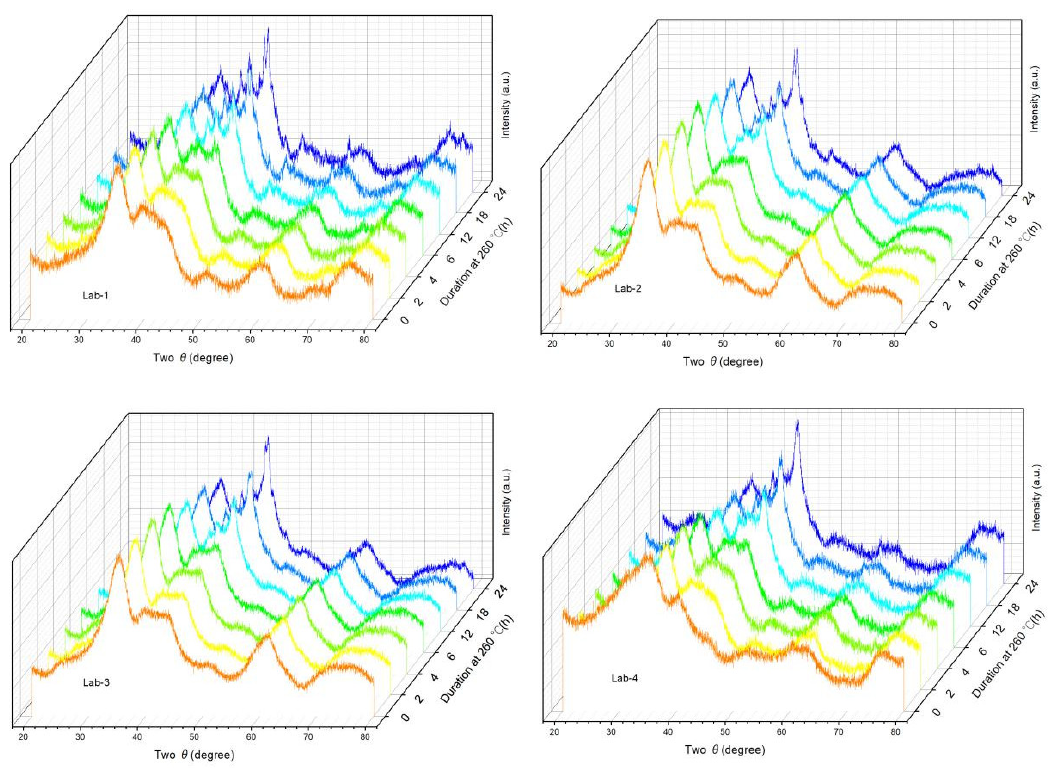
Figure 6. In situ XRD pattern of calcined samples during syngas reduction procedure (H 2 /CO = 20, from an ambient temperature up to 260 °C, and maintained at 260 °C).